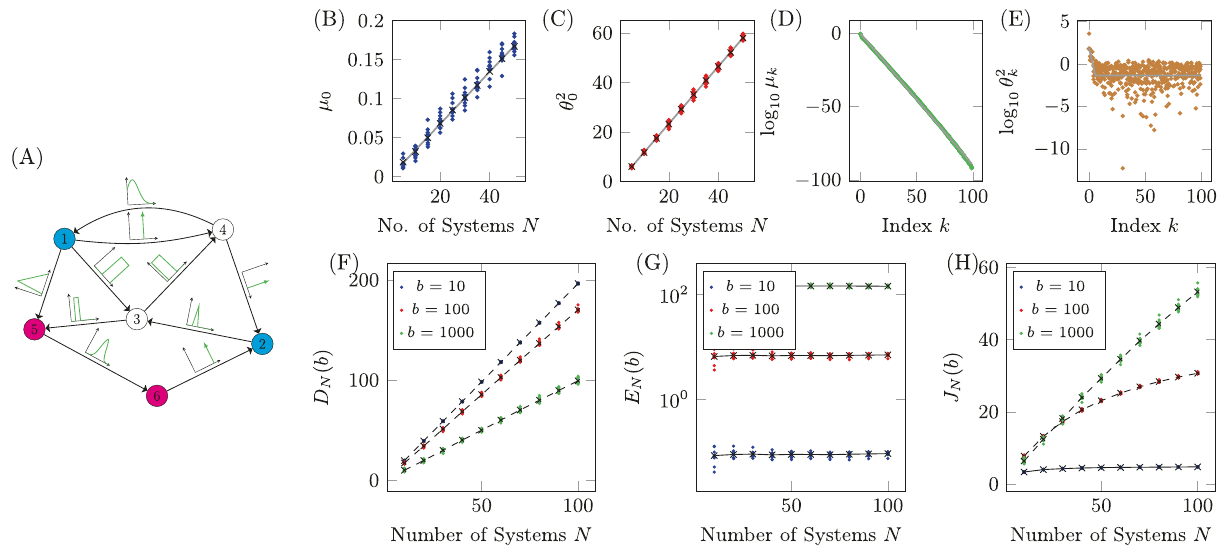
Fig. 4 A network with uncertain edge weights. A The diagram of the network with six nodes and 10 edges. Each edge weight is drawn from the distribution shown in the associated plot, with numerical values for the distributions shown in Table 1. Additionally, there is a negative self-loop assigned to each node drawn from the uniform distribution U ð 2 ; 4 Þ . The largest eigenvalues μ 0 and associated values θ 2 are shown as marks in B and C , respectively, 0 where the average for each N is shown as a black cross and the gray lines are linear fi ts. For N = 50, the full spectrum of μ k is plotted in D and the corresponding values θ 2 k are plotted in E . The gray lines represent the curves found after fi tting the expressions in Assumptions 1 and 2. The cost terms (deviation, control energy, and total cost) for b = 10, b = 100, and b = 1000 are shown in panels F – H , respectively. The black marks are the averages over the 10 realizations for each value of N and the dashed lines are for the viewer.